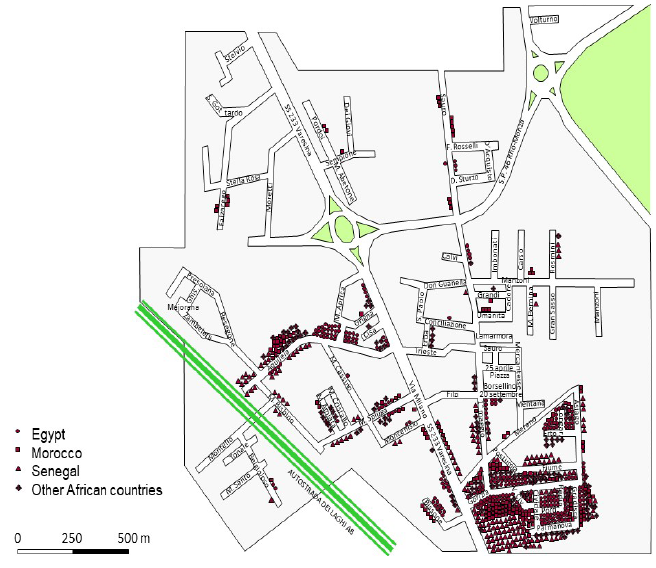
Fig. 6 Map of the urban area of Baranzate shows the housing location of Africans. Immigrants from other continents roughly follow the same distribution pattern (Lucarno,